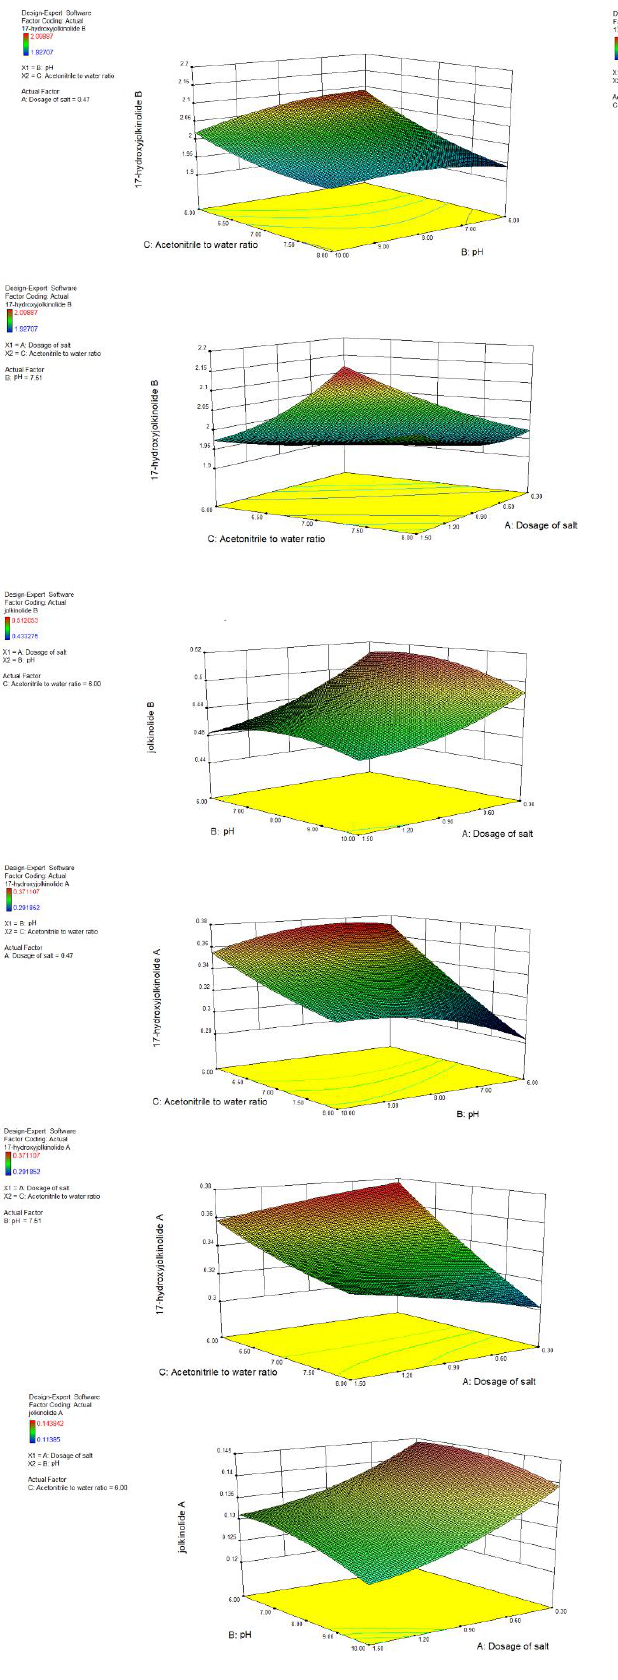
Figure 10. 3D plots of the response surface for the contents of four diterpenoids as related to dosage of salt, pH of water, and acetonitrile to water